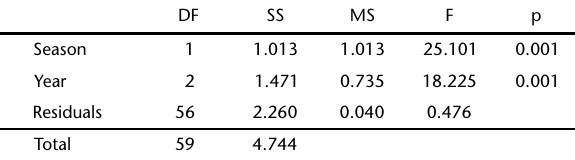
Table 2. MANOVA results for limnological intra and inter-annual among the studied streams were considered as factors the years studied (inter-annual) and the seasons (intra-annual).